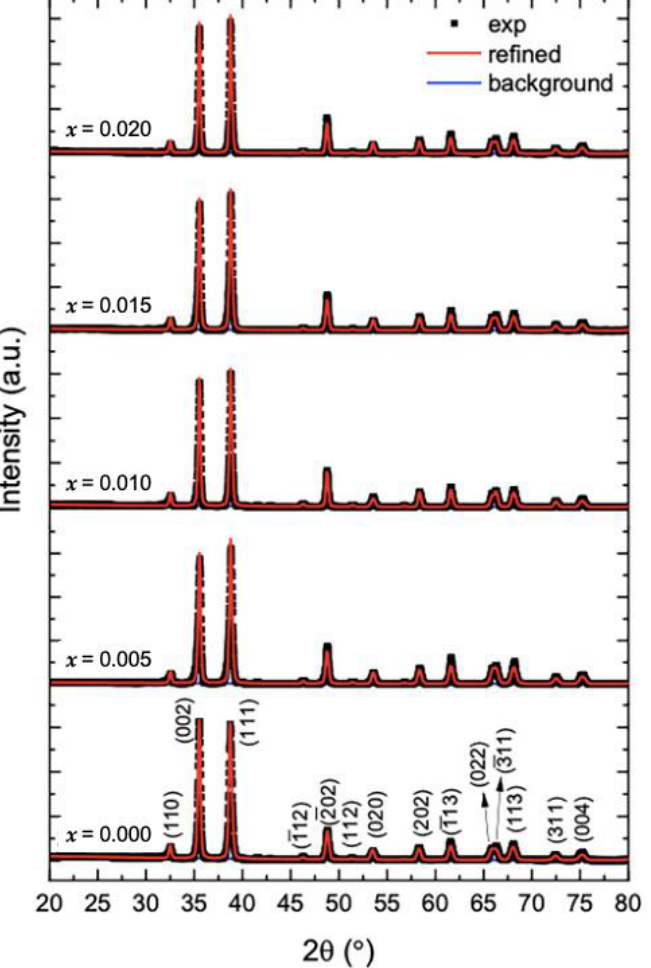
Figure 1. Refinements of the XRD patterns of undoped and Mg-doped CuO NPs (Cu 1 −x Mg x O NPs).